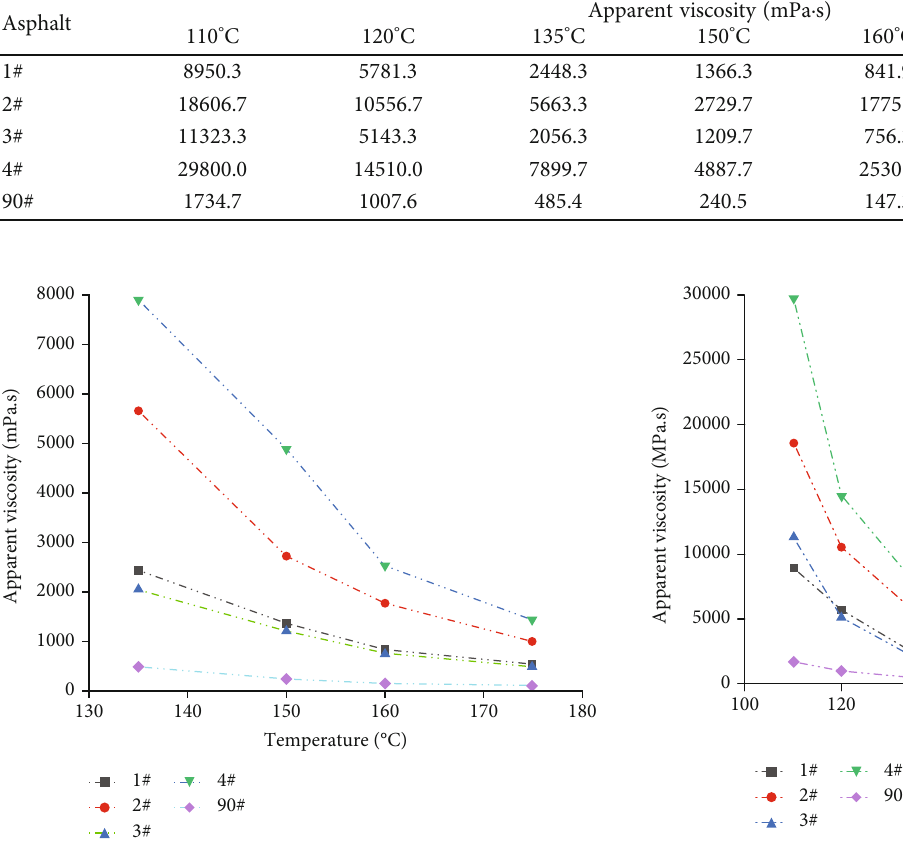
Figure 9: Viscosity-temperature curve of tire rubber powder- modi fi ed asphalt at full